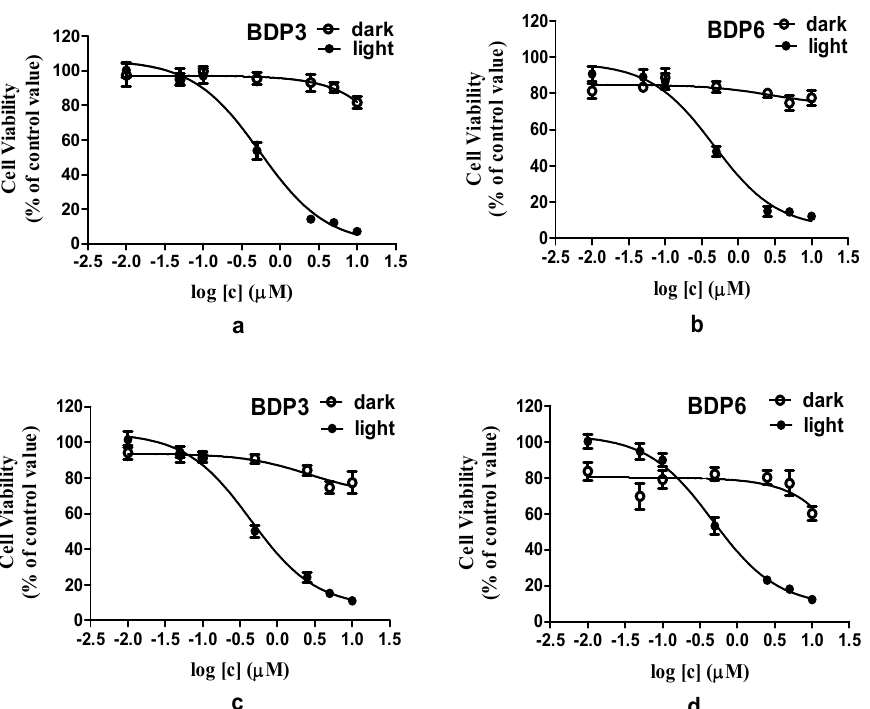
Figure 3. Effects of BDP3 and BDP6 on HepG2 (a , b ) and HeLa ( c , d ) cells in dark ( ○ ) and in light (●) ( λ = 660 nm, 1.5 J/cm 2 ). Data are expressed as Mean ± SEM of three independent experiments; six replicates were used for each concentration in each experiment.